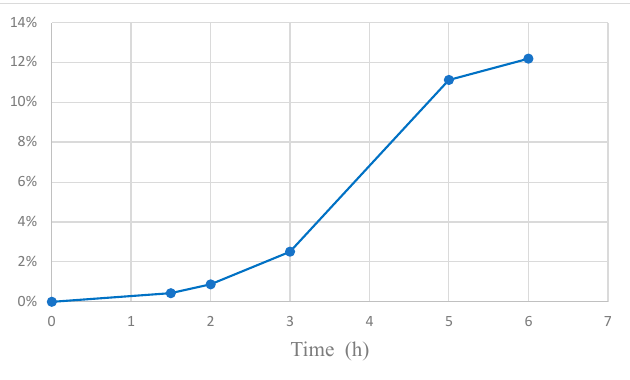
Figure 10. Percentage of ferulic acid (FA) that passed from Liquid 2 to the reactor vs. time. The operating conditions are the same as those in Figure 8.